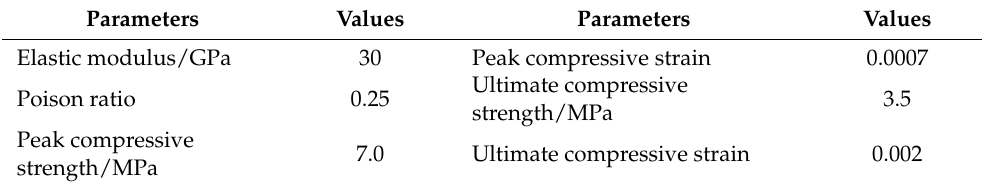
Table 3. Concrete material parameters of the prototype underground